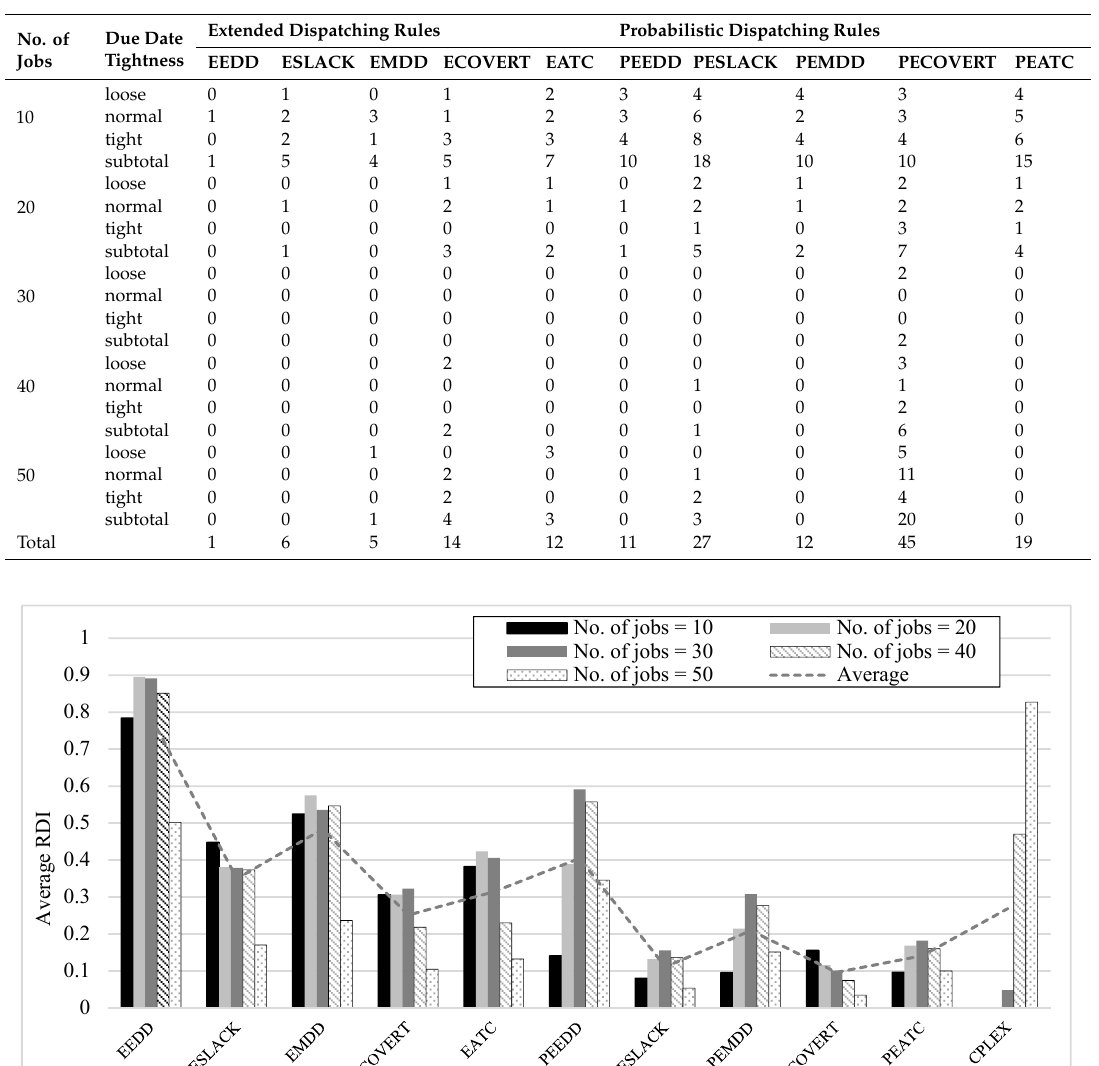
Table 3. Number of the best solutions found by extended dispatching rules and their probabilistic versions.